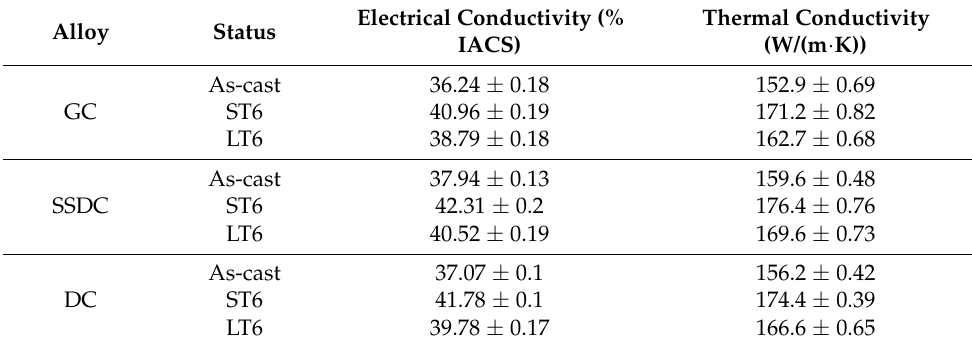
Figure 6. Alloys in different states: ( a ) electrical conductivity ( b ) thermal conductivity. Table 4. Electrical and thermal conductivity of the alloys.